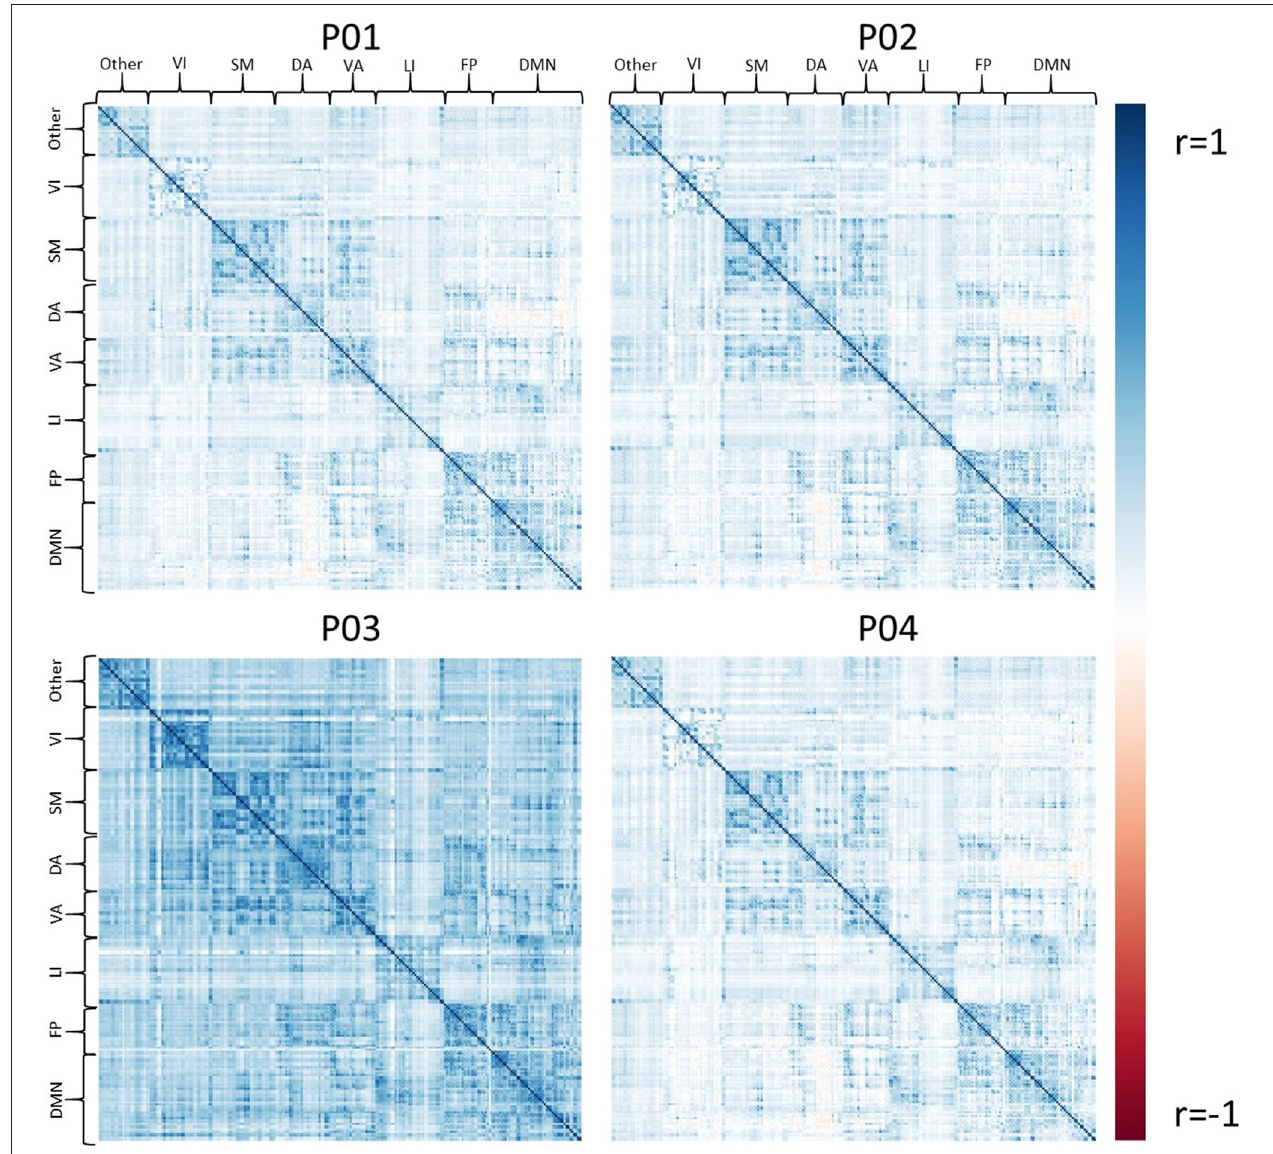
FIGURE 4 | The set of group average correlation matrices from resting state with: P01 (linear registration), P02 (nonlinear registration + RETROICOR correction), P03 (fMRIPrep), P04 (P02 + aEREMCOR).